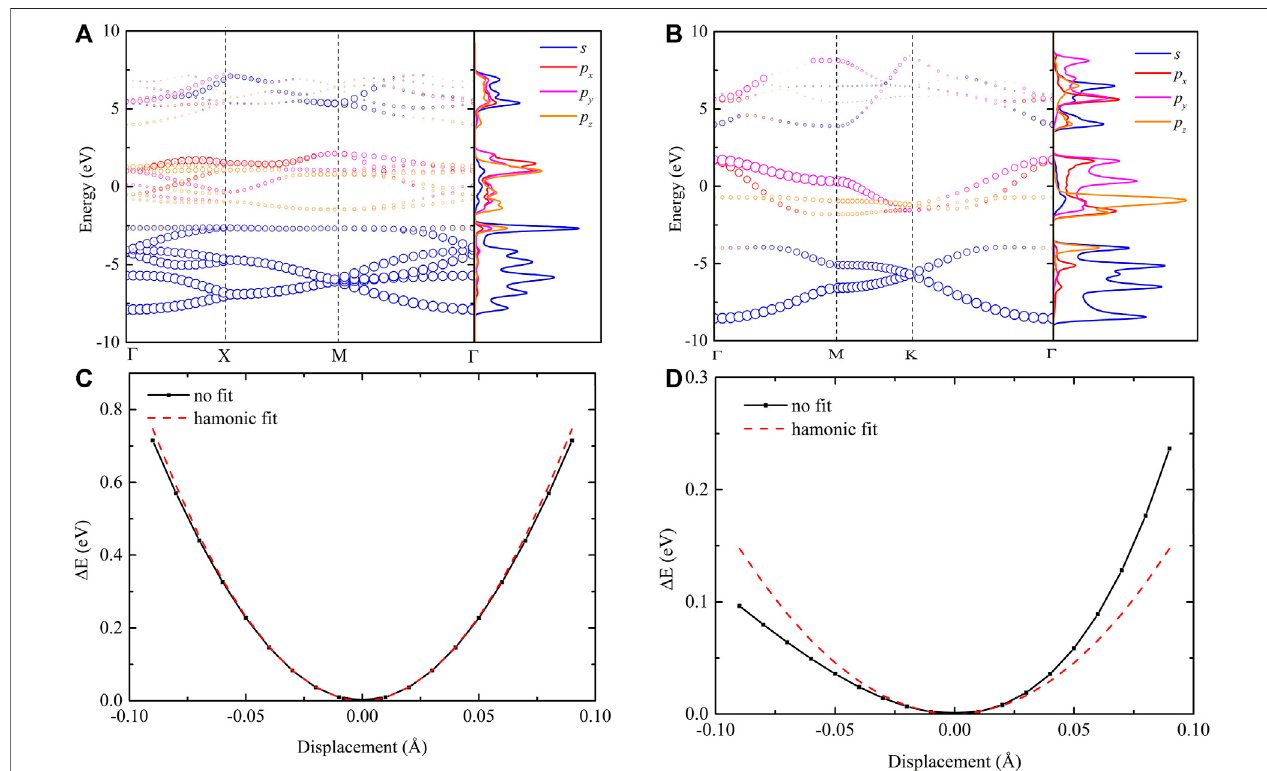
FIGURE8|(Top) Orbitalprojectedelectronicstructuresprojectedon s , p x , p y and p z orbitalsofSiatominpenta-SiH (A) andH-silicene (B) ,respectively. (Bottom) The total energy change as a function of displacement of Si atoms in penta-SiH (C) and H-silicene (D) as well as harmonic fi tting (red dashed line),